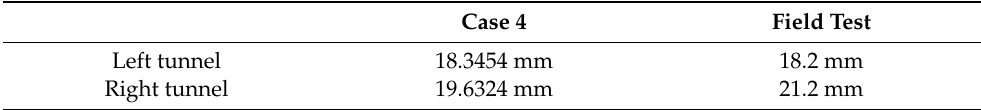
Figure 10. Vault settlement time history curve. Table 3. Case 4 and ZK0+710 measured surface settlement.